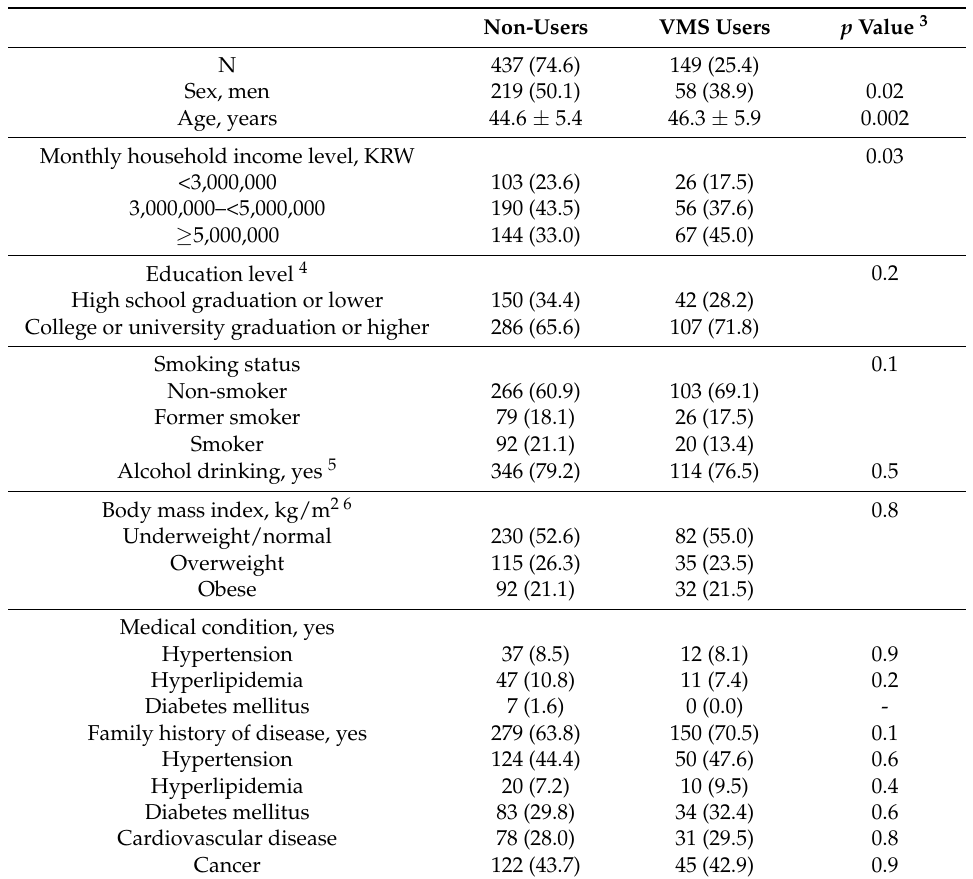
Table 1. General characteristics of the participants by use of vitamin and mineral supplements (VMS) 1,2 ( n =